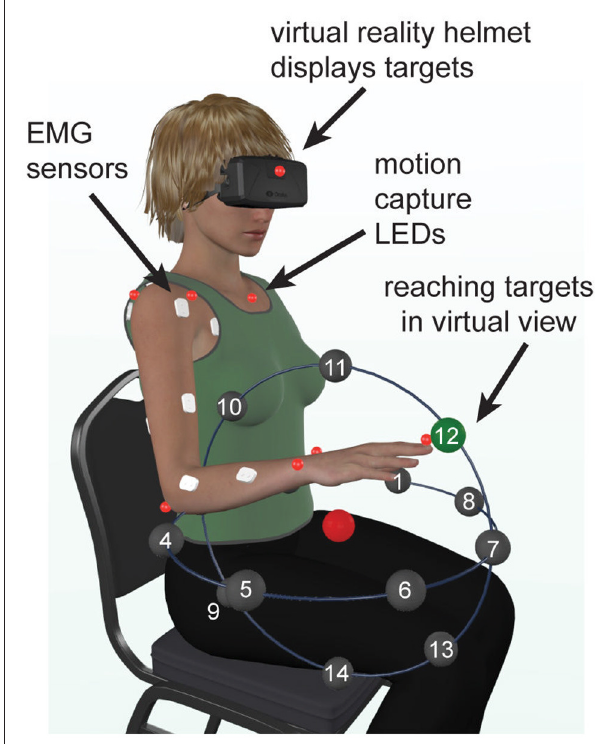
FIGURE 1 | Experimental setup. Illustration showing the locations of reaching targets, arranged in a semi-spherical pattern in virtual reality, relative to the physical location of the subject. The central target is shown in red and one of the goal targets is shown in green.